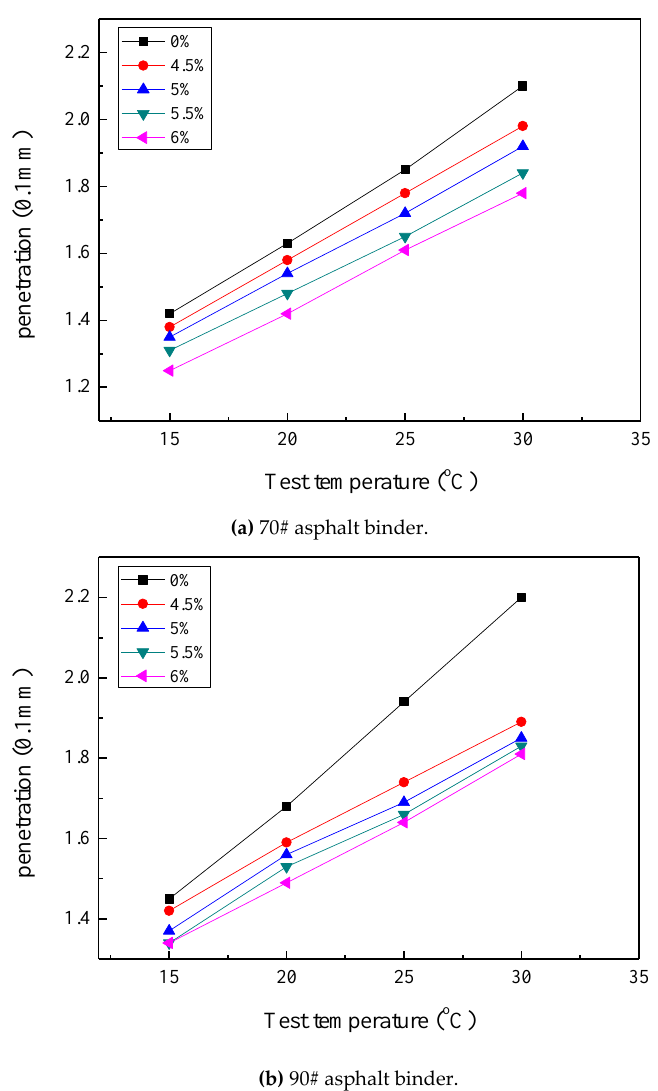
Figure 1. Penetration test of matrix asphalt and SBS modified asphalt.